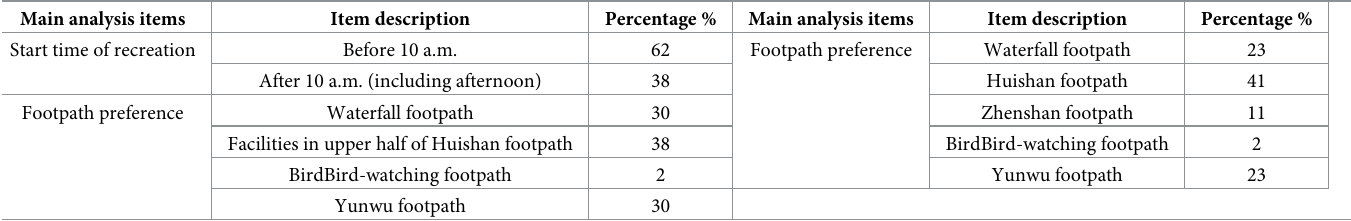
Table 3. The analysis results of the visiting times and preferred pathways and facilities within the Guanwu National Forest Recreation Area in Taiwan by tourists. Main analysis items